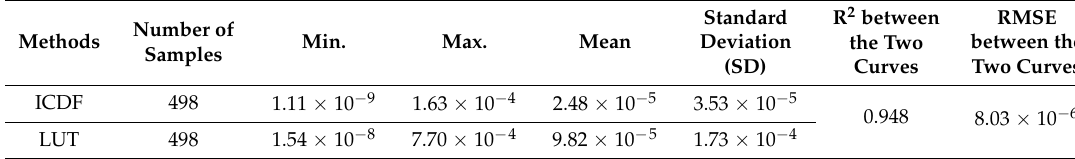
Table 2. The statistics of the curves in Figure 1 by the two